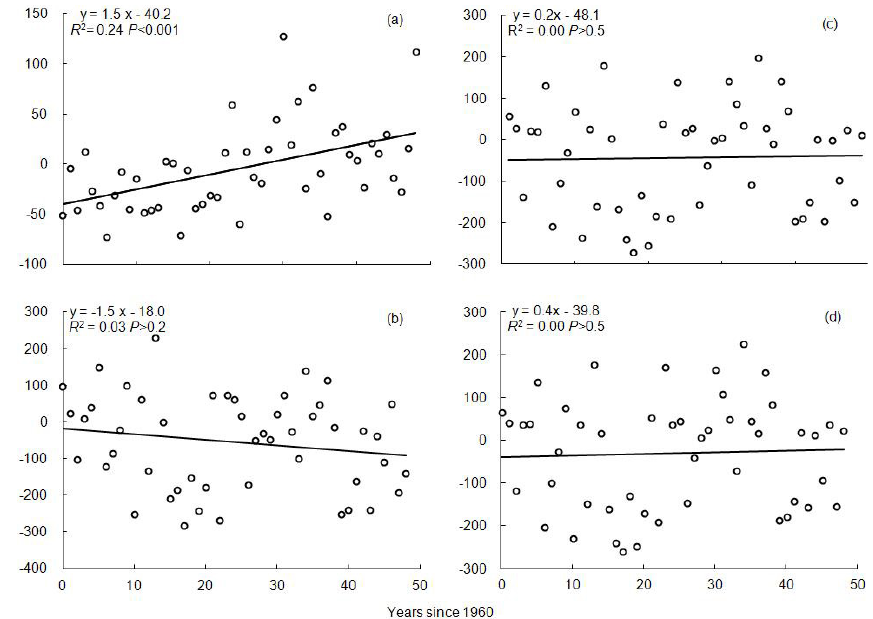
Fig. 5. Impact of air temperature (a) , precipitation (b) , air temperature and precipitation (c) , air temperature, precipitation and net radiation (d) on area-weighted CH 4 flux. Estimated IF i by Eq. CF